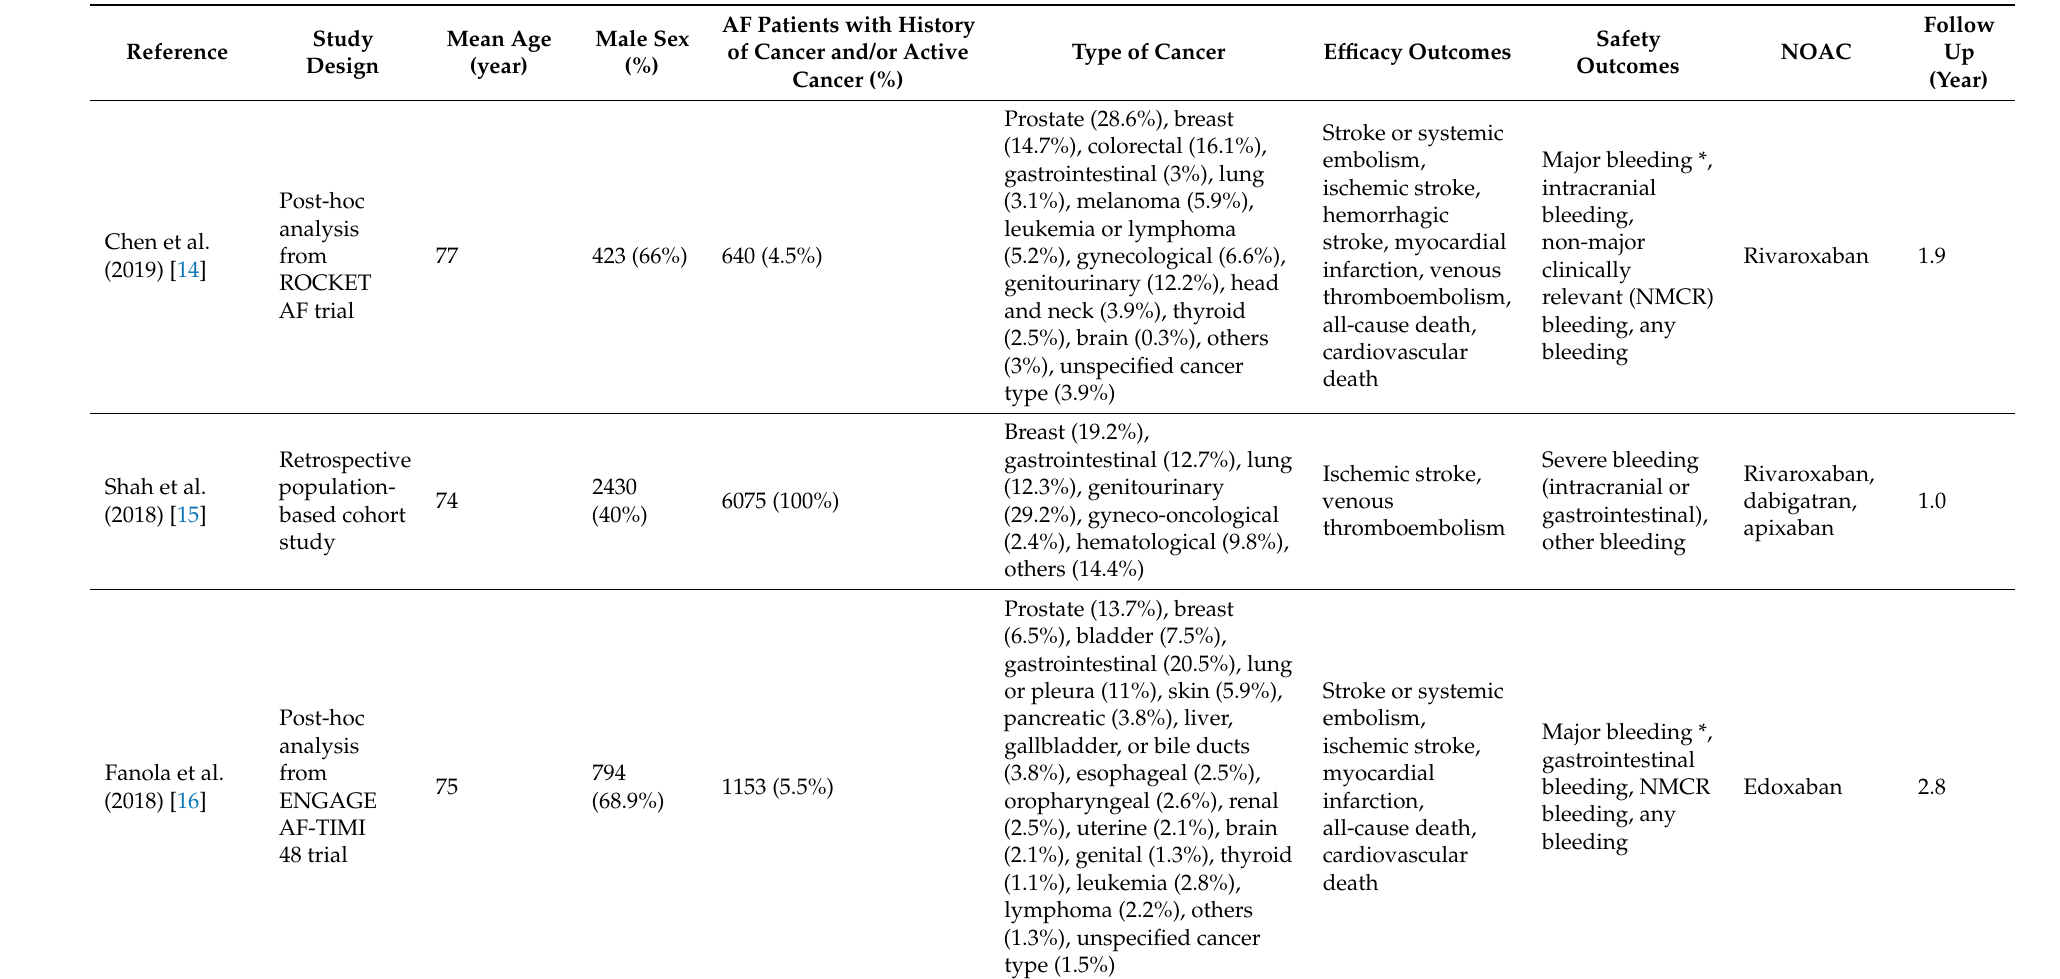
Table 1. Efficacy and Safety outcomes of NAOCs in AF cancer